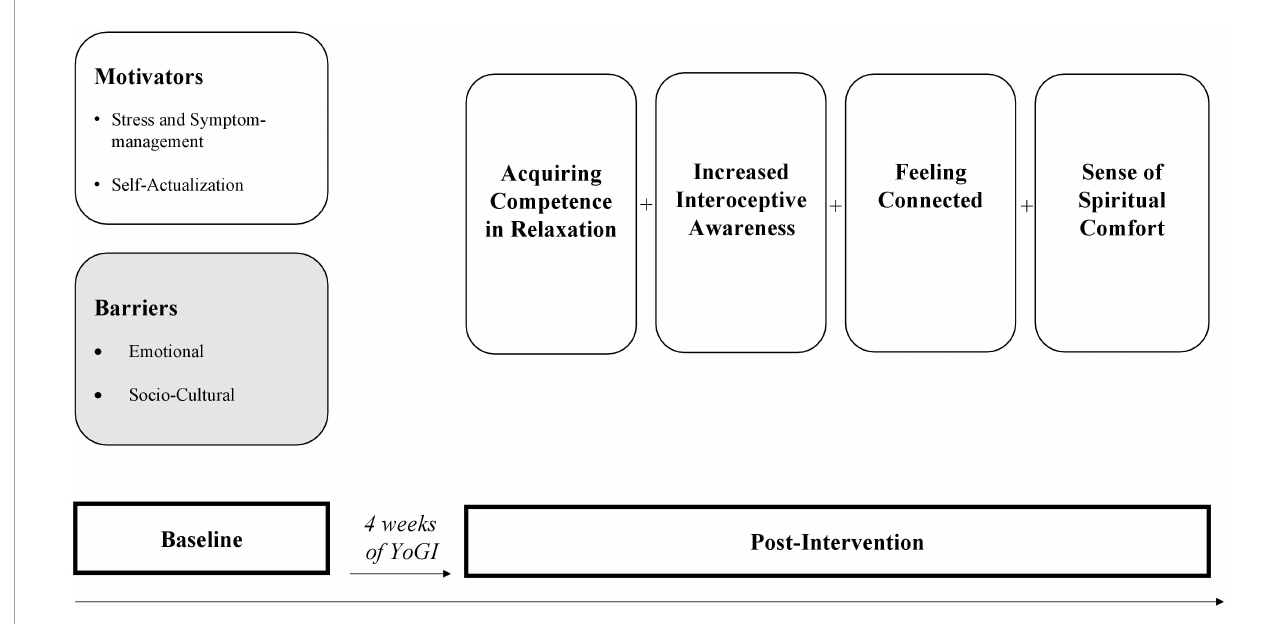
FIGURE3 Longitudinal experience of yoga-based group intervention